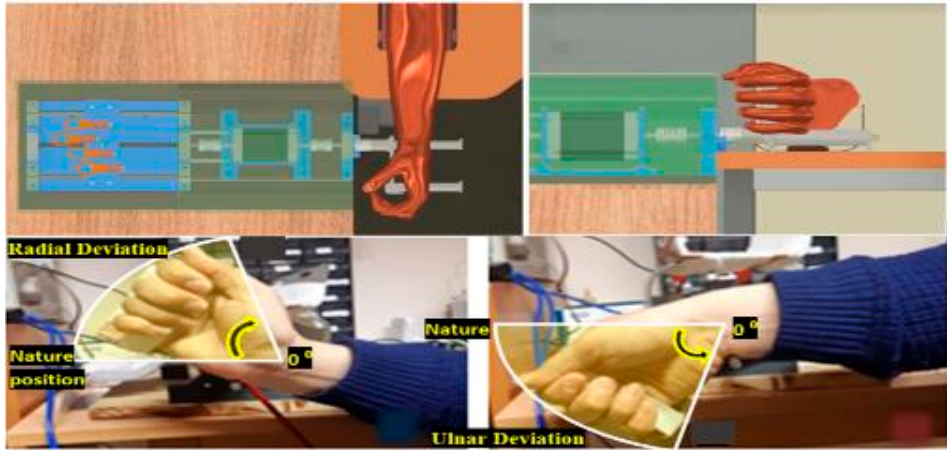
Figure 5. 3D model structure and health object integration with the proposed wrist radial/ulnar deviation R/U attachment mechanism.